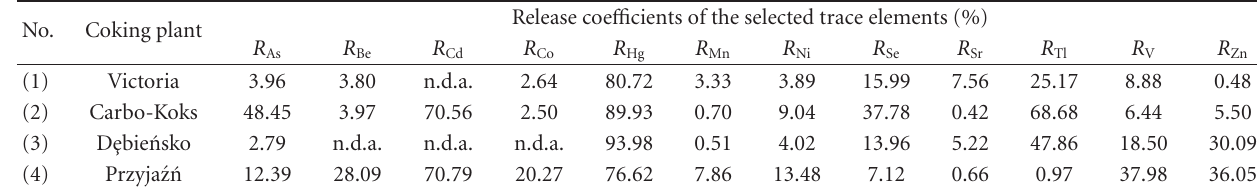
Table 5: Release coe ffi cients of the selected trace elements.